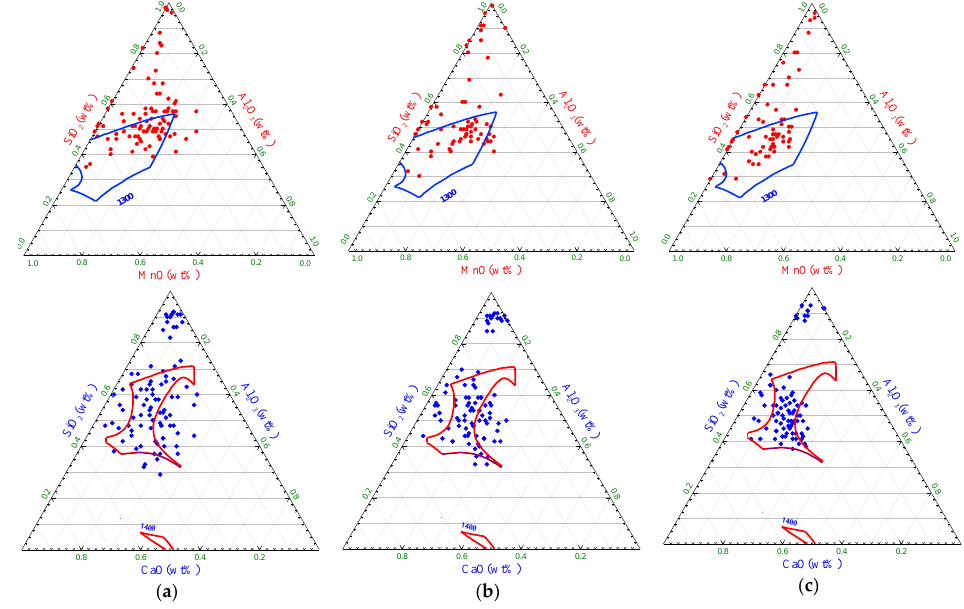
Figure 5. Inclusion distribution overlaid on phase diagram with refining time in 5 # steel sample: ( a ) 900 s (15 min); ( b ) 1800 s (30 min); ( c ) 2700 s (45 min).